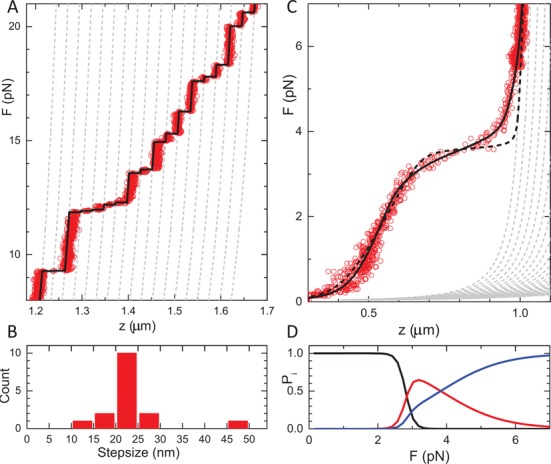
Detailed analysis of the unfolding of a single chromatin fiber. (A) A zoom in on the high-force region shows discrete steps in extension. Dashed gray lines represent the extensions of all states that are composed of extended and fully unwrapped nucleosomes. The fit match was obtained for \documentclass[12pt]{minimal}
\usepackage{amsmath}
\usepackage{wasysym} 
\usepackage{amsfonts} 
\usepackage{amssymb} 
\usepackage{amsbsy}
\usepackage{upgreek}
\usepackage{mathrsfs}
\setlength{\oddsidemargin}{-69pt}
\begin{document}
}{}$z$\end{document}ext = 4.6 nm. The black line shows the best match between individual data points and the various states of unwrapping. (B) Step size distribution of the data shown in (A) obtained from a 10-point window t-test analysis. (C) Unfolding of a 15*197 NRL chromatin fiber at low force. Below 7 pN the extension starts to deviate from a string of extended nucleosomes (gray dashed lines). A single transition (black dashed line) does not capture the force-extension data. The black line shows a fit to Equation (8), while constraining Lwrap = 89 bp and \documentclass[12pt]{minimal}
\usepackage{amsmath}
\usepackage{wasysym} 
\usepackage{amsfonts} 
\usepackage{amssymb} 
\usepackage{amsbsy}
\usepackage{upgreek}
\usepackage{mathrsfs}
\setlength{\oddsidemargin}{-69pt}
\begin{document}
}{}$z$\end{document}ext = 4.6 nm, yielding \documentclass[12pt]{minimal}
\usepackage{amsmath}
\usepackage{wasysym} 
\usepackage{amsfonts} 
\usepackage{amssymb} 
\usepackage{amsbsy}
\usepackage{upgreek}
\usepackage{mathrsfs}
\setlength{\oddsidemargin}{-69pt}
\begin{document}
}{}$\Delta G_{1}^{{\rm fiber}}$\end{document}= 21.2±0.1 kBT, ΔG2= 4.3±0.1 kBT. (D) The corresponding probability for a nucleosome to be in a fiber (low force), a single wrap (intermediate force) or in the extended conformation (high force).